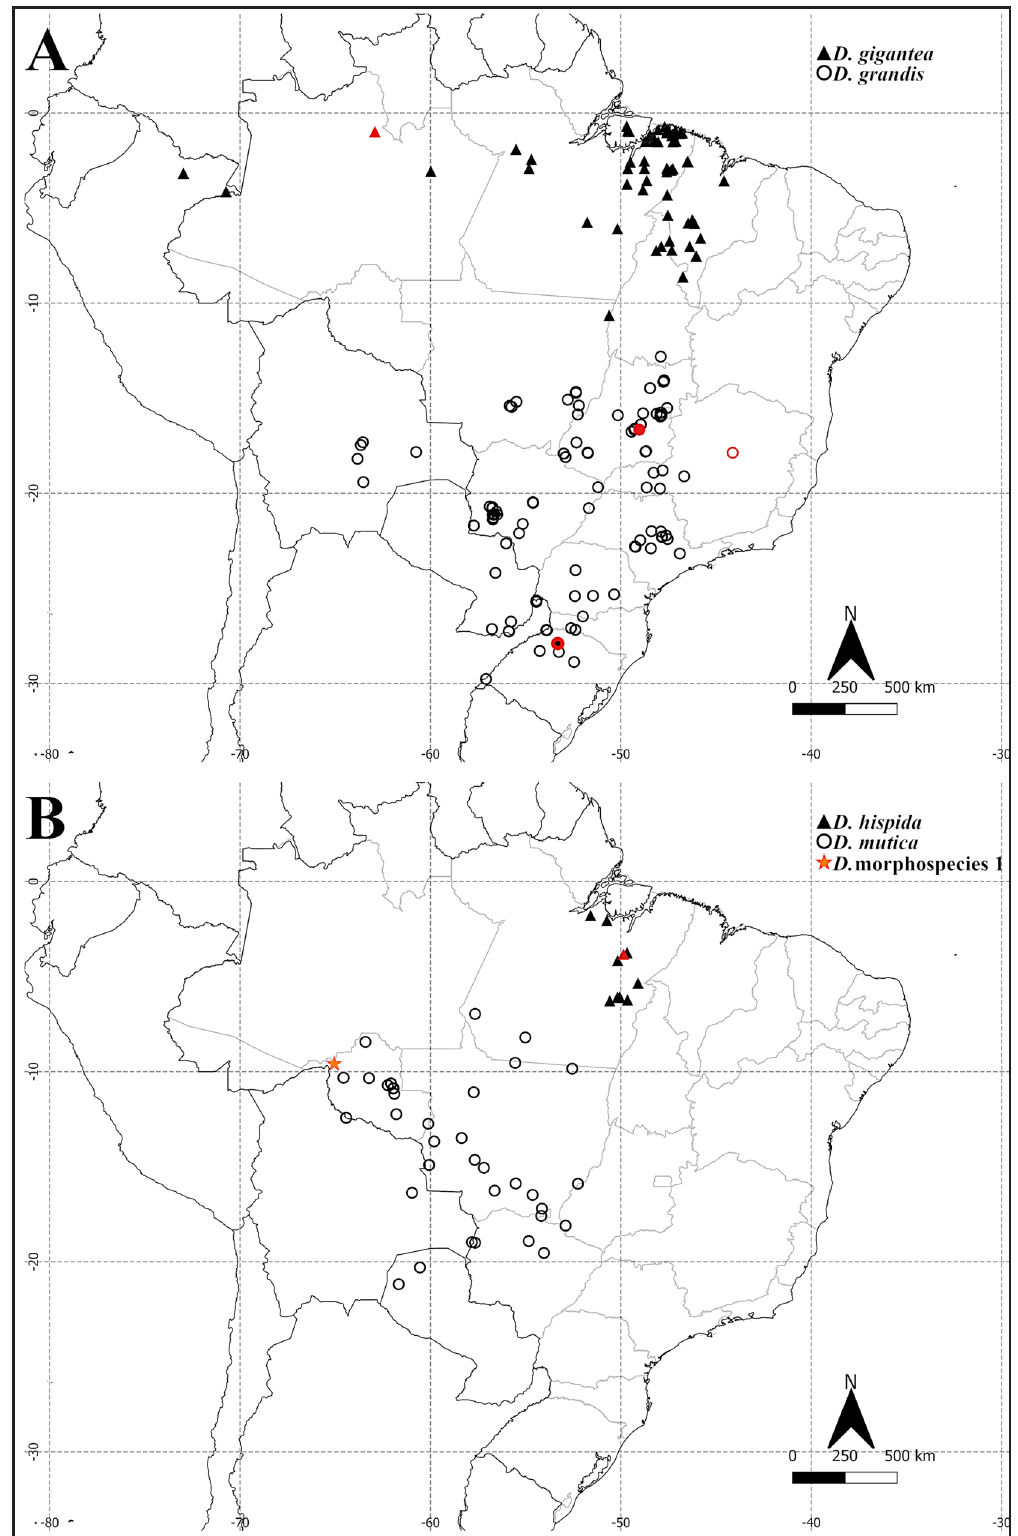
Fig. 28. Distribution maps for species of Dinoponera Roger, 1861. Red symbols indicate type specimens examined here. A . D. gigantea (Perty, 1833) and D. grandis Guérin-Méneville, 1838. B . D.